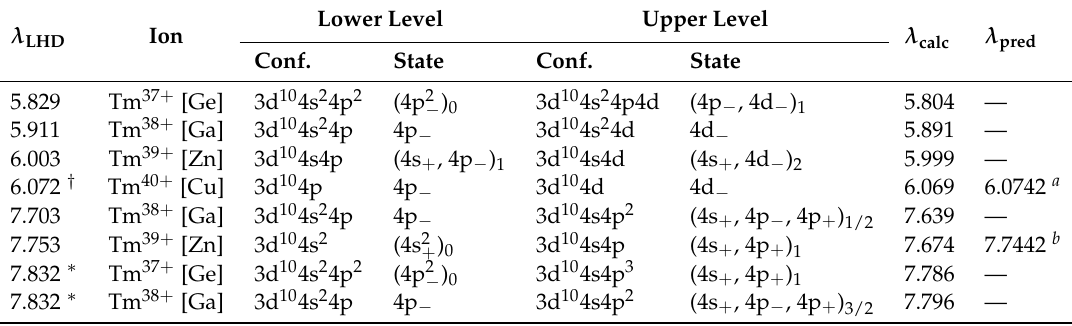
Figure 1. Soft X-ray spectra of thulium (top panel), erbium (middle panel), and samarium (bottom panel) ions recorded in LHD plasmas under high-temperature conditions. The peak electron temperature for each spectrum is shown in each panel. The assignments of the spectral lines indicated by arrows are summarized in Tables 1–3. Table 1. The assignments of the lines of thulium ions indicated by arrows in the top panel of Figure 1. The assignments are based on a CR model constructed based on the Hullac code. Isoelectronic sequence of each ion is shown in a square bracket. The states of the lower and upper levels are denoted in jj coupling notation. All wavelengths are in nm. The calculated ( λ calc ) and predicted ( λ pred ) wavelengths are shown in the last two columns. References: a [45], b [46].